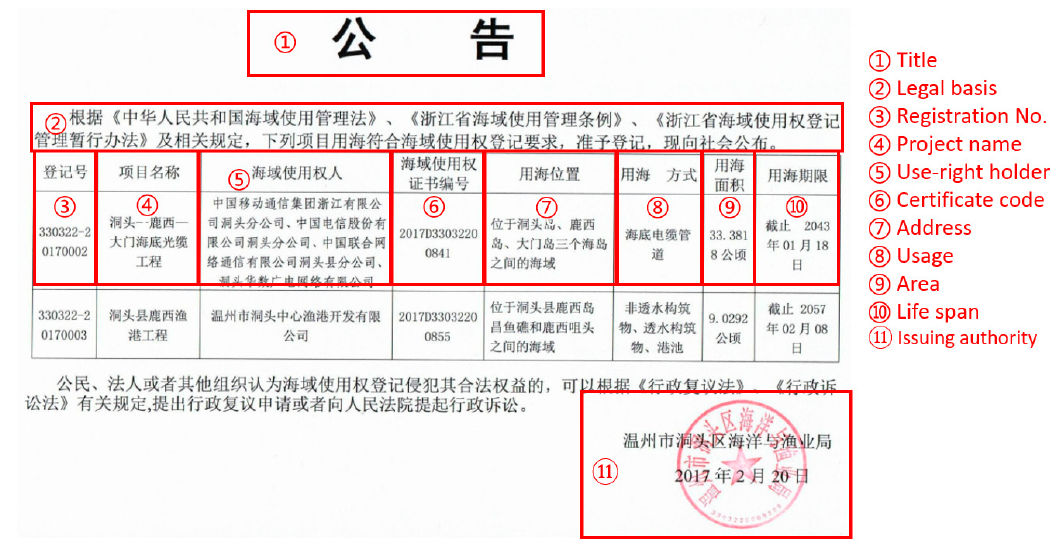
Figure 14. Registration table of a sea area (source: http://zjjcmspublic.oss-cn-hangzhou-zwynet-d01-a.internet.cloud.zj.gov.cn/jcms_files/jcms1/web1832/site/picture/0/1702201120428293339.jpg, accessed on 26 October 2021).